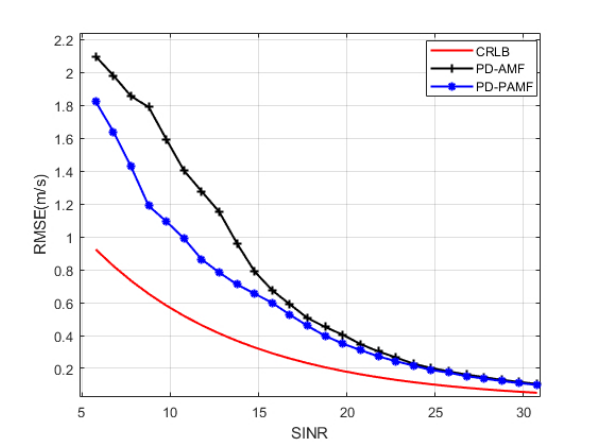
Figure 5. Root Mean Square Error (RMSE) of velocity versus signal-to-interference-and-noise ratio (SINR), AR(3), P FA = 10 − 2 , K =